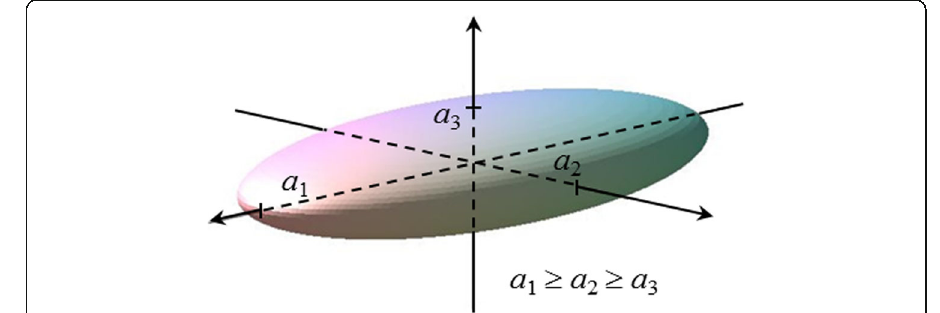
Fig. 1 Ellipsoid with semi-axis of length a 1 , a 2 and a